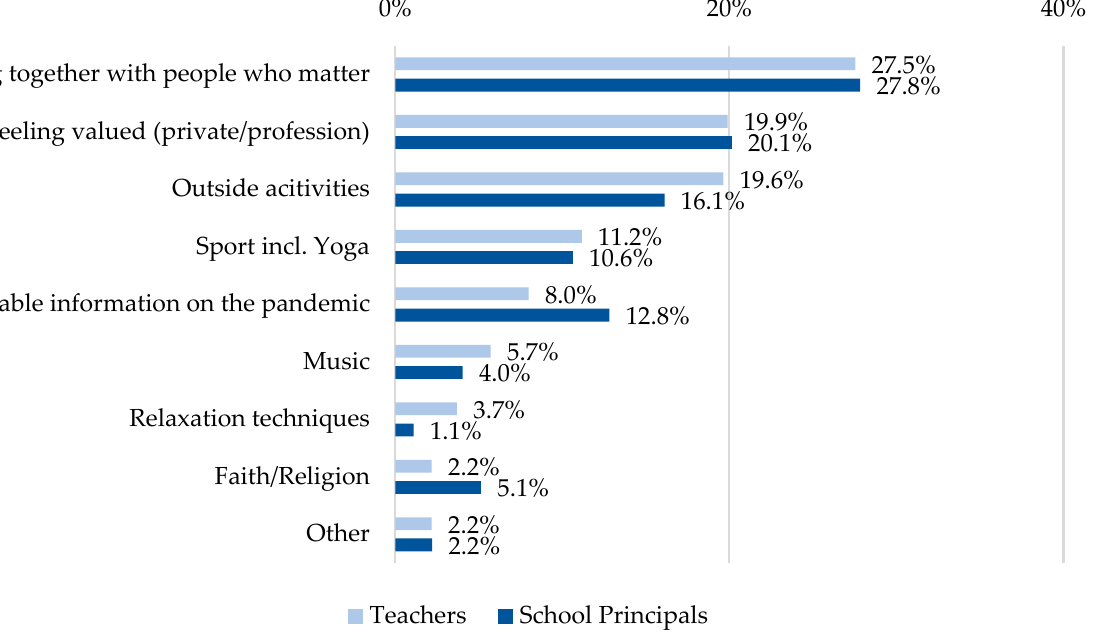
Figure 3. What do you feel supported by and can draw strength from during the pandemic? (Multiple answers possible).